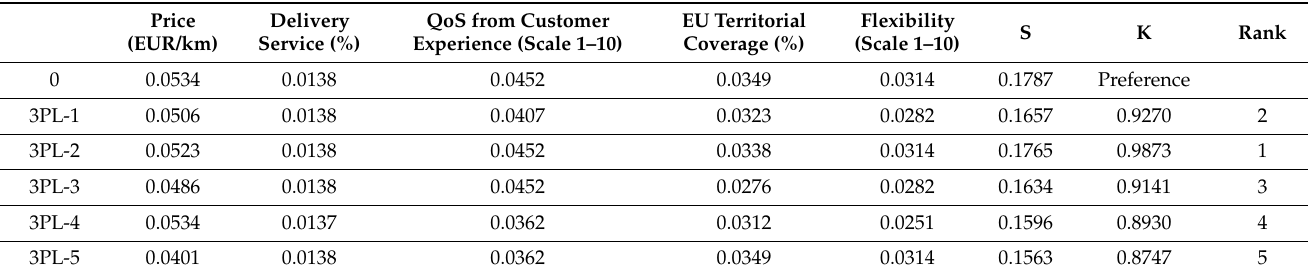
Table 13. Weighted D–M matrix (Source: Authors).